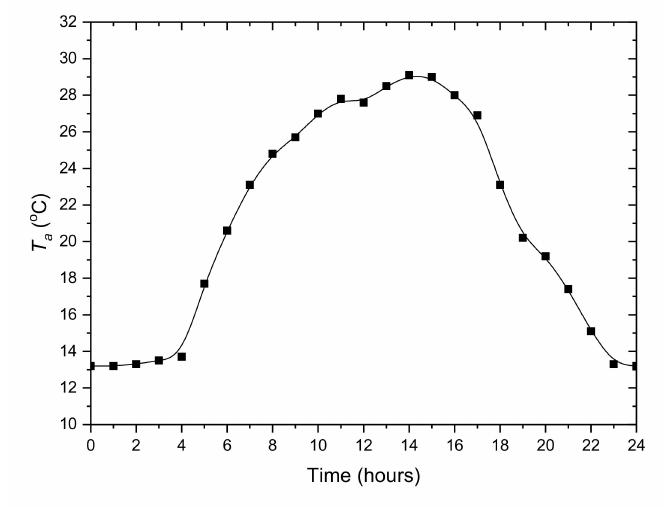
Figure 4. Hourly profile of the ambient temperature adopted for modelling.